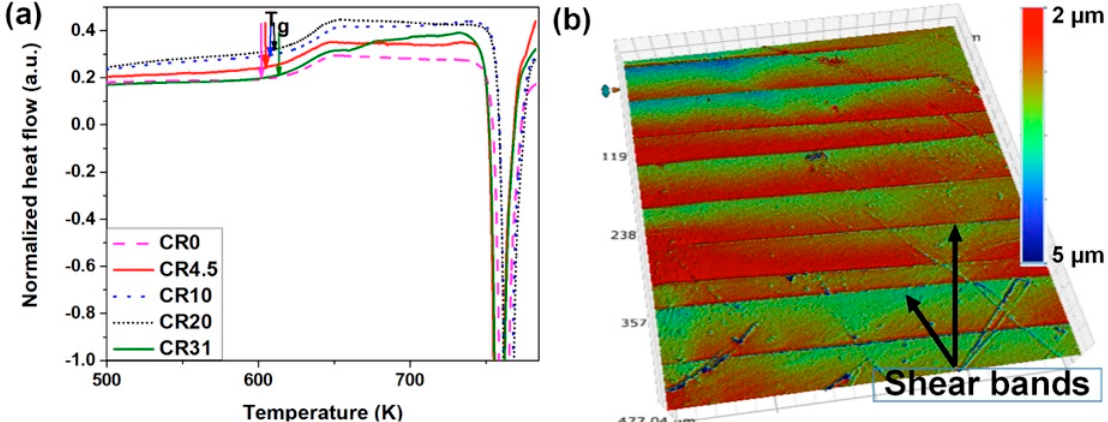
Figure 4. ( a ) Differential scanning calorimeter (DSC) plots of CR0, CR4.5, CR10, CR20, and CR31 showing the glass transition event followed by crystallization. ( b ) 3D optical profile showing the evolution of shear bands with step-like features on the surface of CR10.